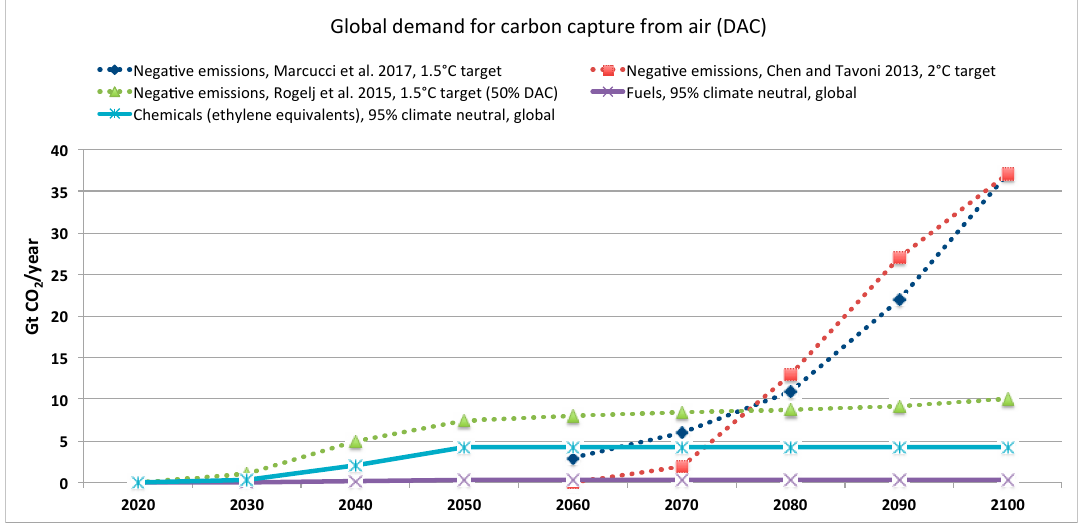
Figure 2. Global Direct Air Capture (DAC) demand for achieving negative emissions from 2060 in comparison with globally required climate-neutral CO 2 for Power-to-Liquids (PtL) and Power-to-Chemicals (PtC) in Gt CO 2 /year.